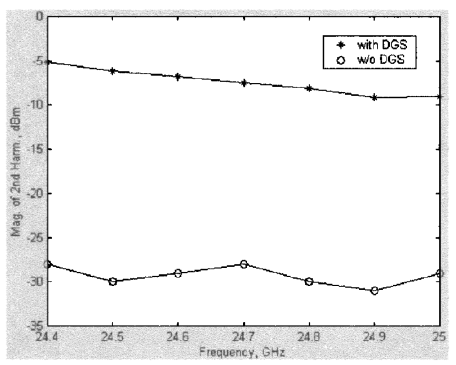
FIGURE 7 Measured 2nd harmonic of VCOs. The bias conditions are V varactor ¼(cid:1) 10V, V GS ¼(cid:1) 1V, V DS ¼ 5V, and I DS